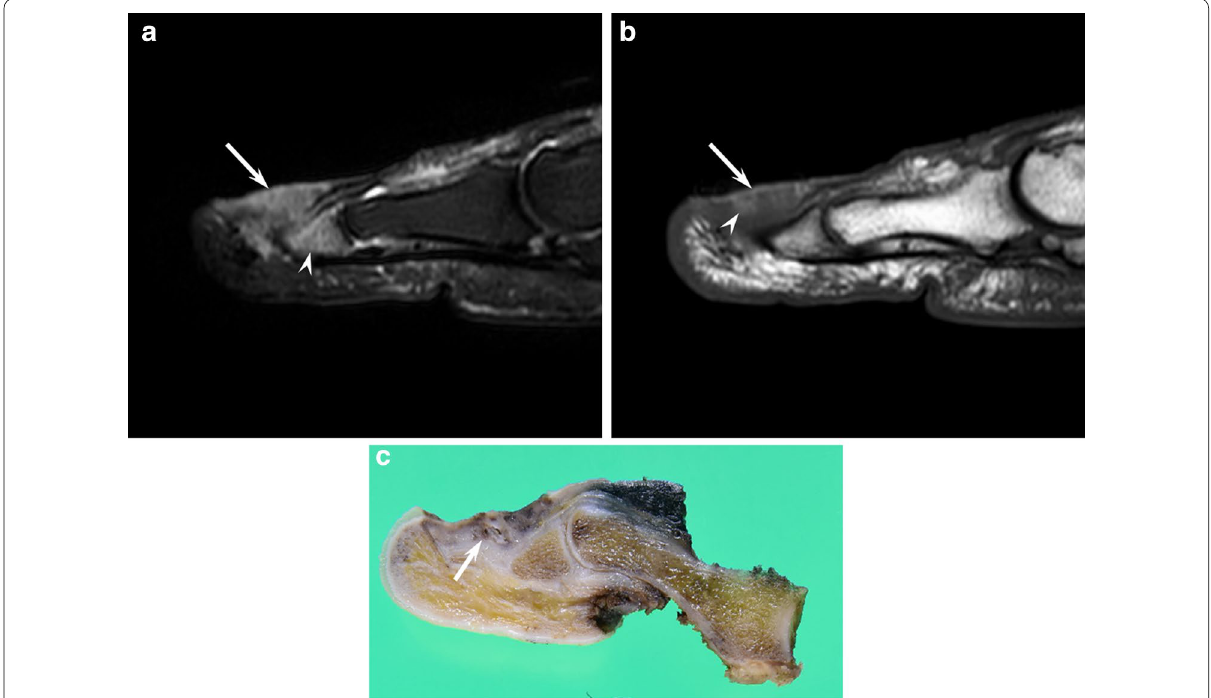
Fig. 4 A 74‑year‑old male with malignant melanoma on the toe. a Sagittal fat‑suppressed T2‑weighted image showing a flattened subcutaneous mass (arrow) with bone marrow edema‑like signal (arrowhead). b Sagittal T1‑weighted image showing an isointense mass (arrow) with intratumoral hyperintensity. c Macroscopic specimen (cut surface) showing intratumoral hemorrhage or melanin deposition